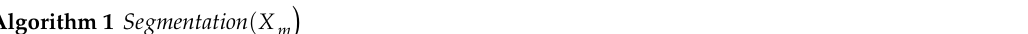
(cid:17) Algorithm 1 Segmentation ( X m Data: Organ inflammations of appendicitis, acute appendicitis, duodenitis and pancreatitis retrieved from